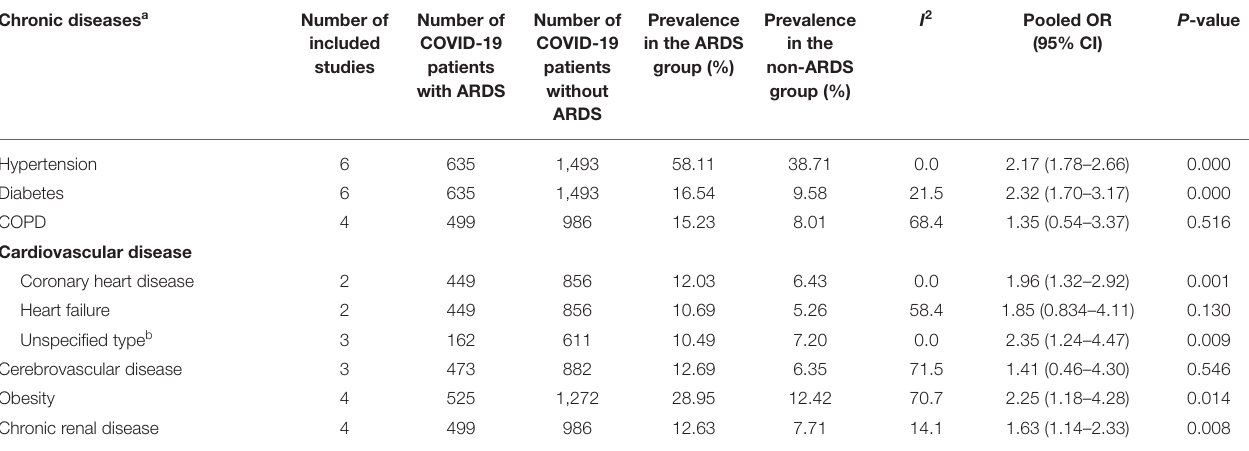
TABLE 5 | Associations between chronic diseases and ARDS of COVID-19.